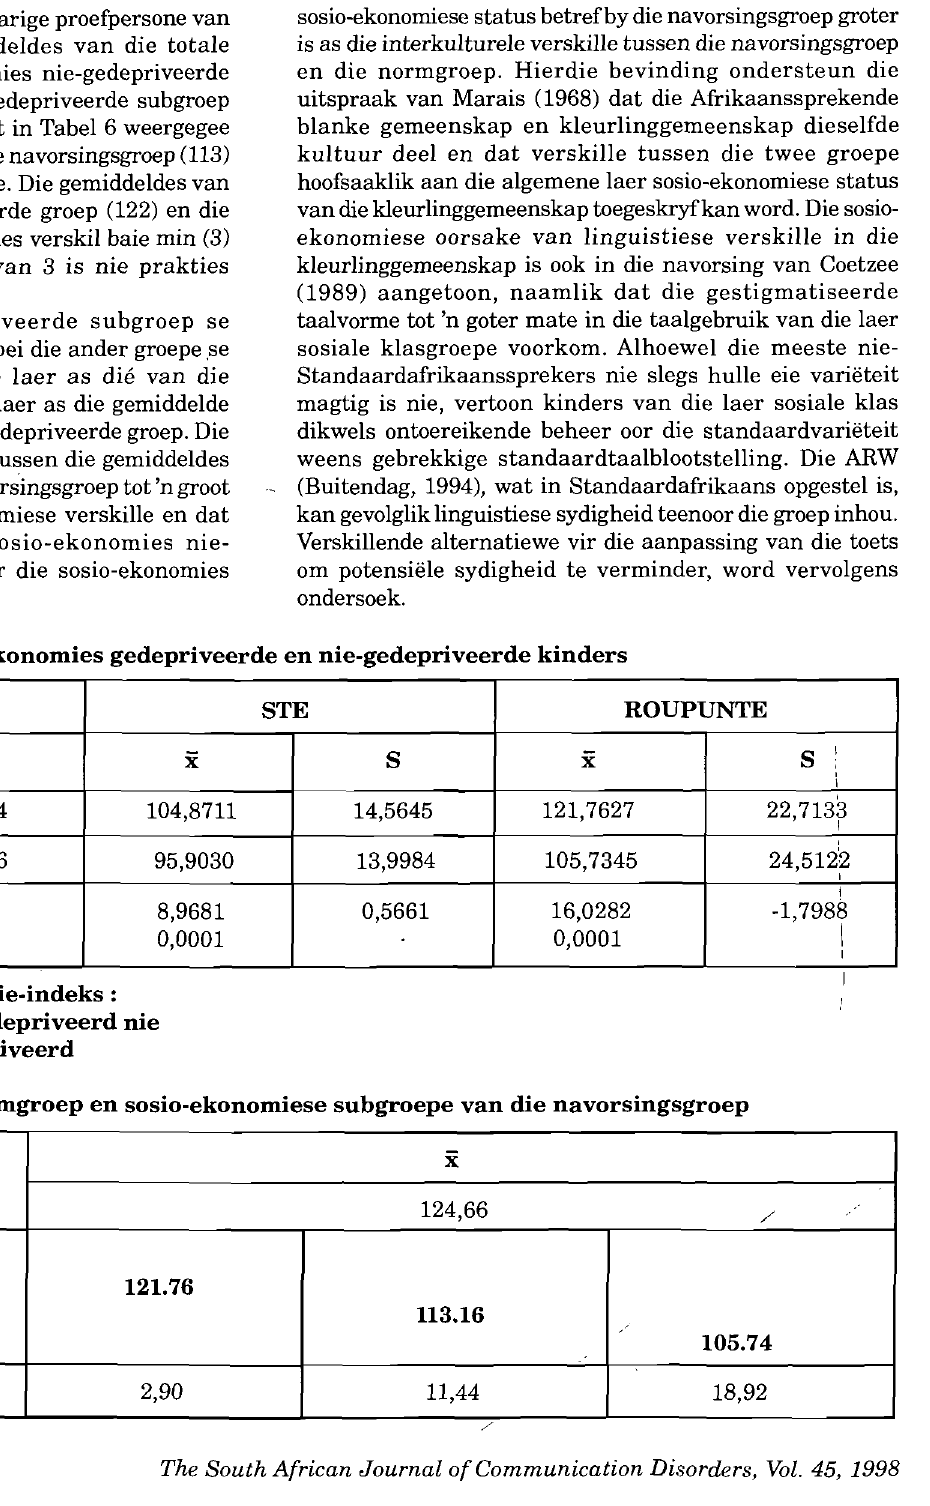
TABEL 6: Roupunte vir die normgroep en sosio-ekonomiese subgroepe van die